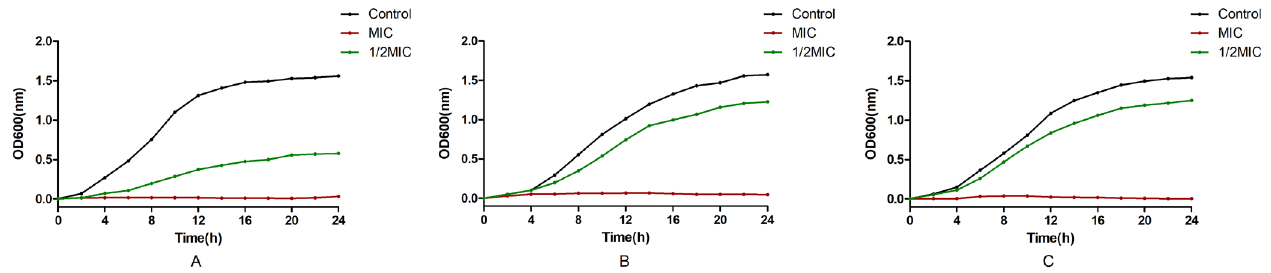
Figure 2. Effect of EOCM ( A ), thymol ( B ) and carvacrol ( C ) on the growth of S. aureus . Error bars represent the standard deviations (SD) of the means from three biological replicates ( n = 3) in an individual experiment.